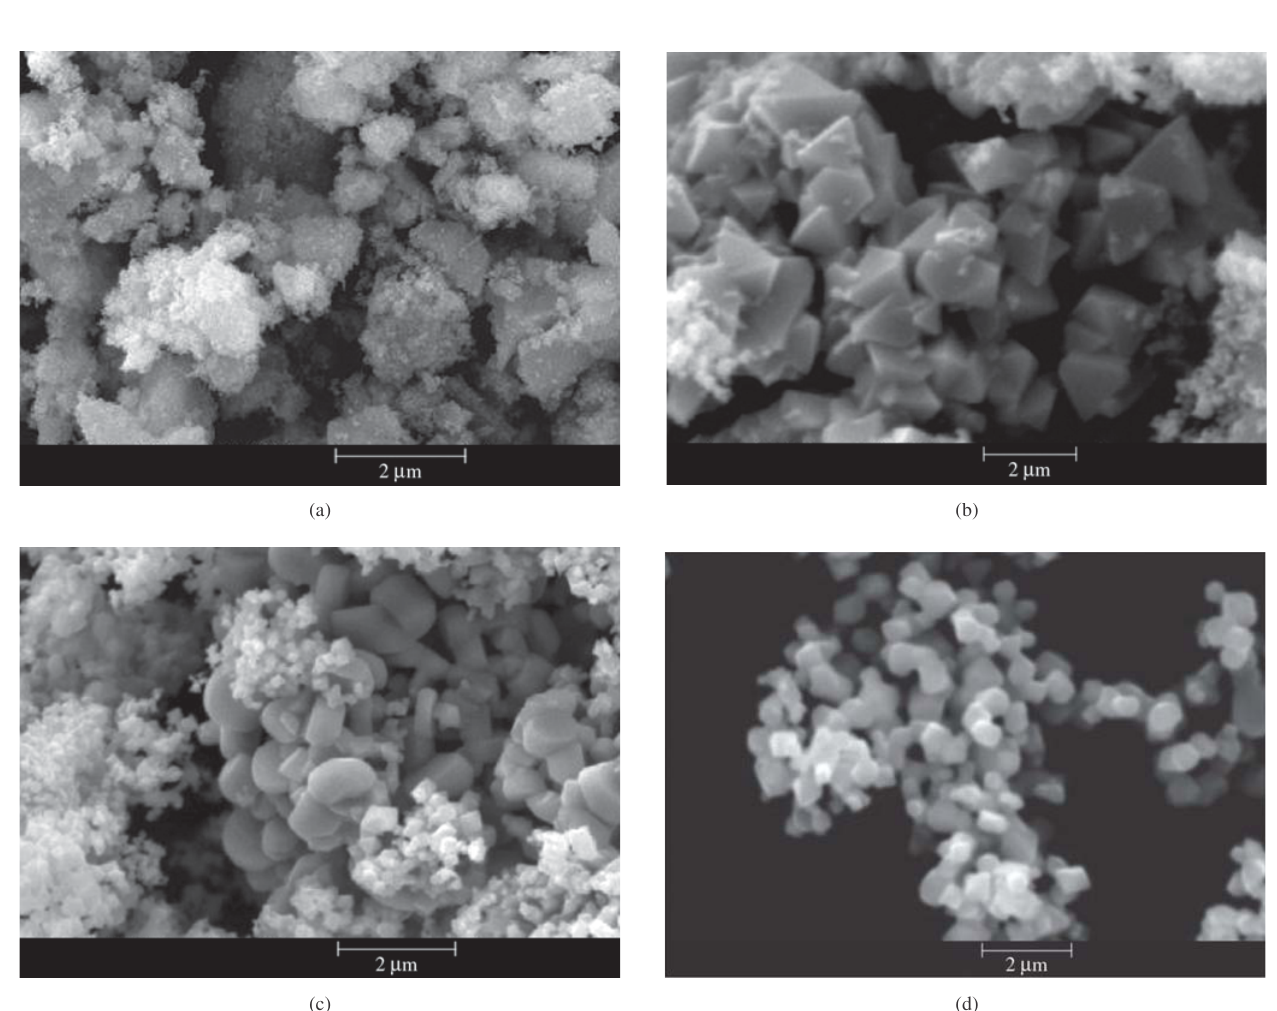
Figure 4. SEM images of powders calcined at: a) 500 °C; b) 700 °C; c) 900 °C for 4 hours; d) 900 °C for 8